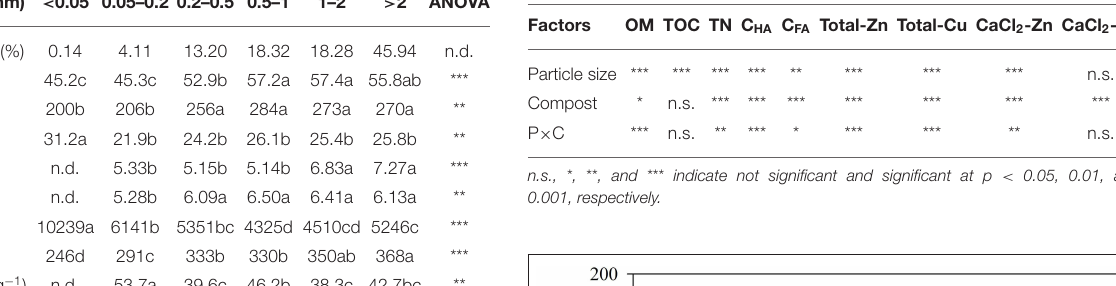
TABLE 5 | Significance of the ANOVA factors for the characteristics of the composts (General Linear Model).